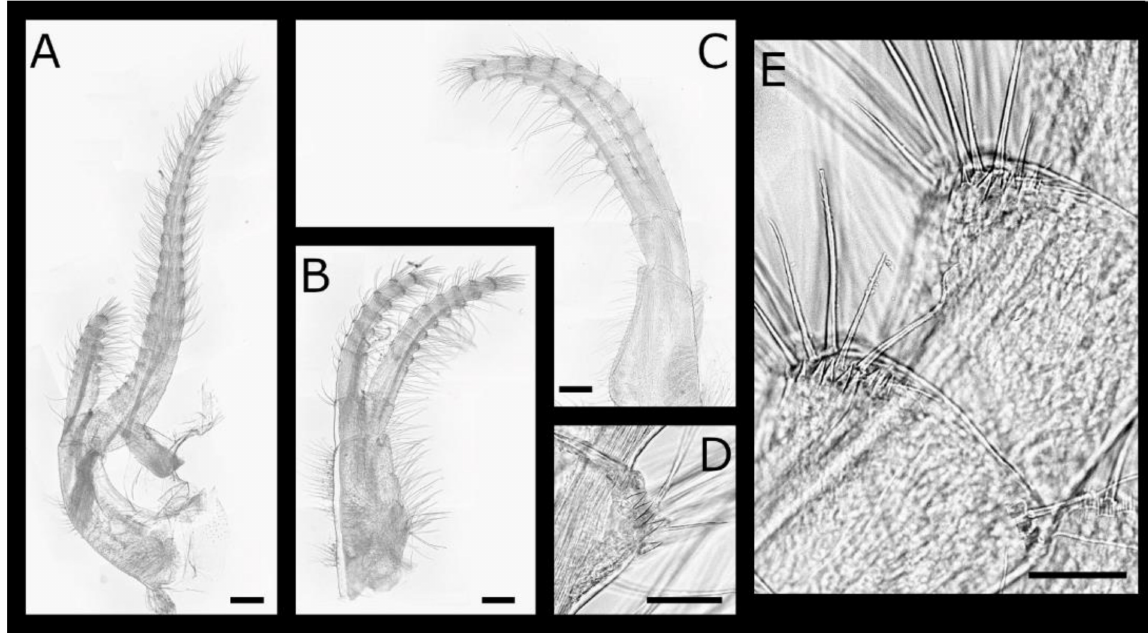
Figure 27. Pectinoacasta sculpturata (Broch, 1931) cirri I–III (WAM C61395). ( A ) left cirrus I; ( B ) left cirrus II; ( C ) right cirrus III; ( D , E ) detail of spines on medial segments of anterior ramus of left and right cirrus III, respectively. Scale bars: A–C = 200 µ m; D–E = 50 µ